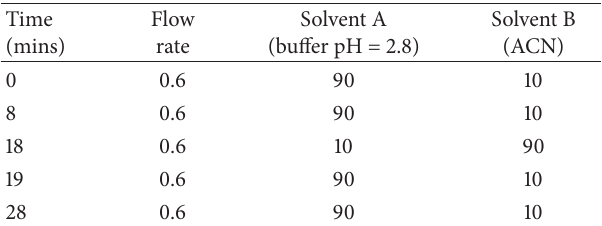
Table 1: Gradient elution